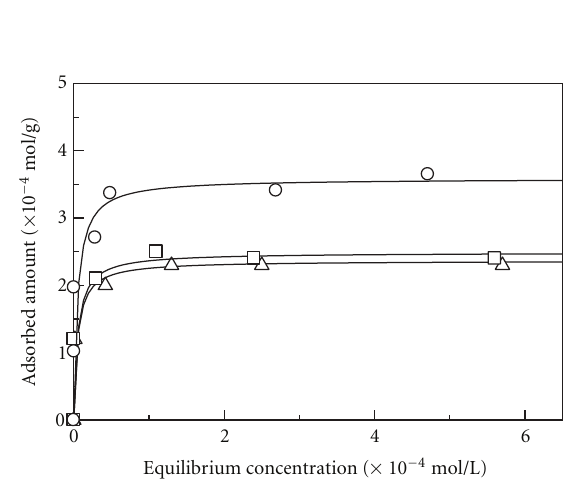
Figure 7: Adsorption isotherms of dye molecules on the titanium oxide nanoparticles in aqueous solution of dye. Aqueous solutions of the dye molecules were the following: (cid:3) , methylene blue; (cid:2) , crystal violet; (cid:2) , Evans blue; (cid:3) , eosin Y. The titanium oxide nano- particles were prepared using the aqueous solution having [NH 3 ] of 1mol/L.